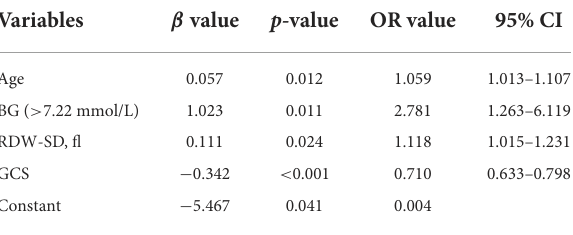
TABLE 2 Results of multivariate logistic